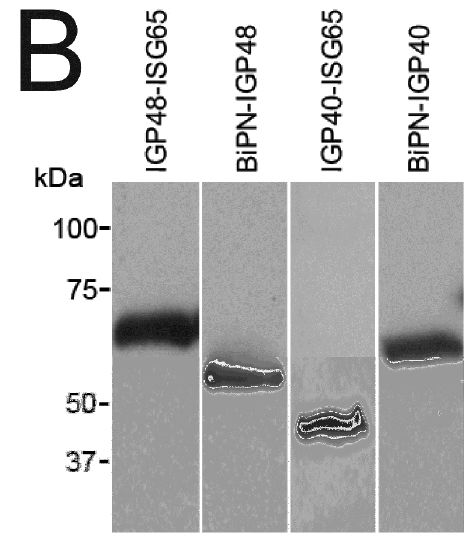
FIGURE 4: Localisation of IGP sorting signals. (A) Im- munofluorescence demonstrating the locations of IGP constructs in BSF trypanosomes. HA-tagged constructs were detected in permeabilised cells with anti-HA anti- body (red). The ER was stained with anti-TbBiP (green) and DNA stained with DAPI (blue). BiPN constructs, in which the lumenal/ecto-domain is replaced by the BiP ATPase domain, no longer co-localise with TbBiP and so are not retained within the ER. (B) Expression of IGP40- HA and IGP48-HA in 427 BSF cells detected by Western blotting using anti-HA antibody. Note that the BiPN chimeras migrate slower than predicted from their molecular weight, an observation that is consistent with the behaviour of BiPN-ISG65 chimeras reported previ- ously [30]. (C) Location of BiPN constructs was deter- mined by co-localisation with p67, Rab5A or Rab11, markers for the lysosome, early or recycling endosomes respectively (green). BiPN-IGP40 and BiPN-IGP48 both demonstrate significant overlap with all three intracellu- lar markers. Scale bar 2